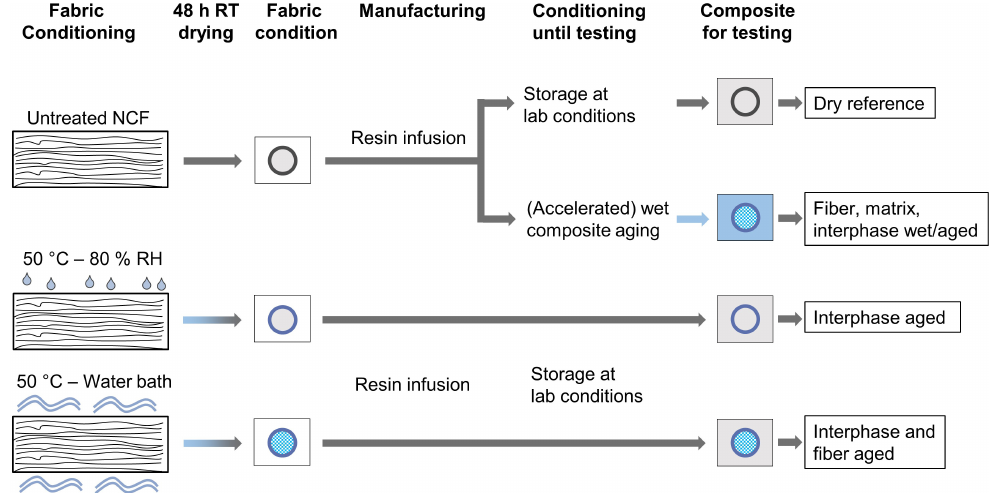
Figure 1. Schematic presentation of classical composite aging and new pre-aging